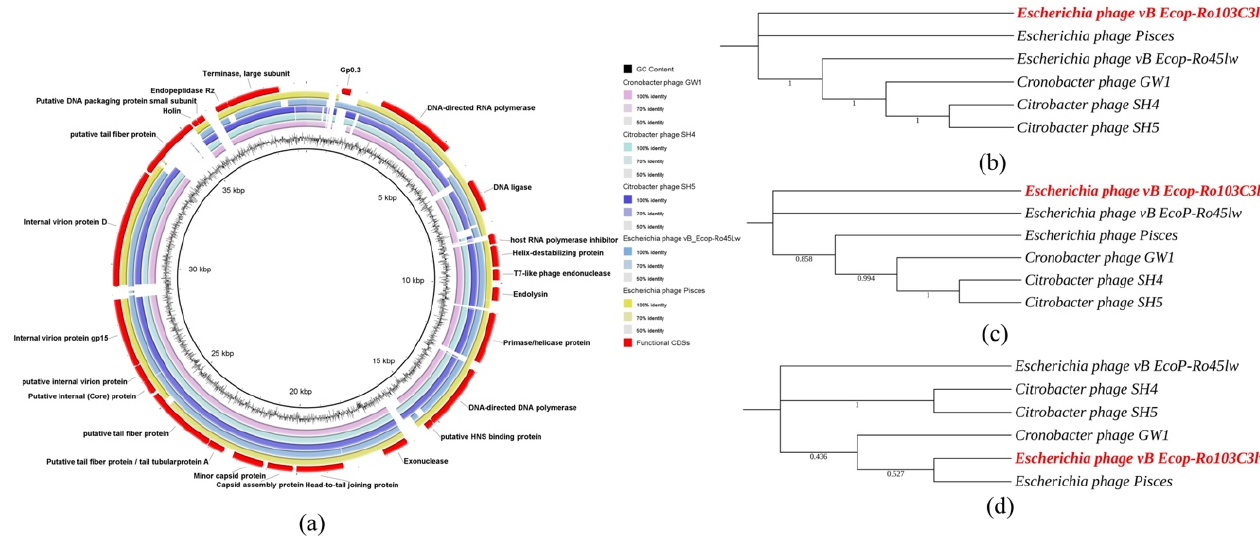
Figure 5. Genomic relationships between Ro103C3lw and its five closely related reference phages. ( a ) Whole-genome comparison of Ro103C3lw and five reference phages using blastn and visualization with BLAST Ring Image Generator (BRIG). The color key coding for five circular maps of reference phage genomes with high sequence identity to Ro103C3lw genome is illustrated in the legend, and the gradients of each color indicate the sequence identity, ranging from 50–100%. The CDSs with the predicted functions from the phage Ro103C3lw are displayed in the outermost ring with red color. ( b – d ) Maximum likelihood phylogenetic analysis of Ro103C3lw (highlighted in red) and the five closely-related reference phages based on the MAFFT alignment of the CDSs associated with ( b ) infection (tail fibers), ( c ) host cell lysis (lysin, holin, and spanin), and ( d ) DNA packaging (terminases). Numbers next to the branches are bootstrap values (500 replicates).